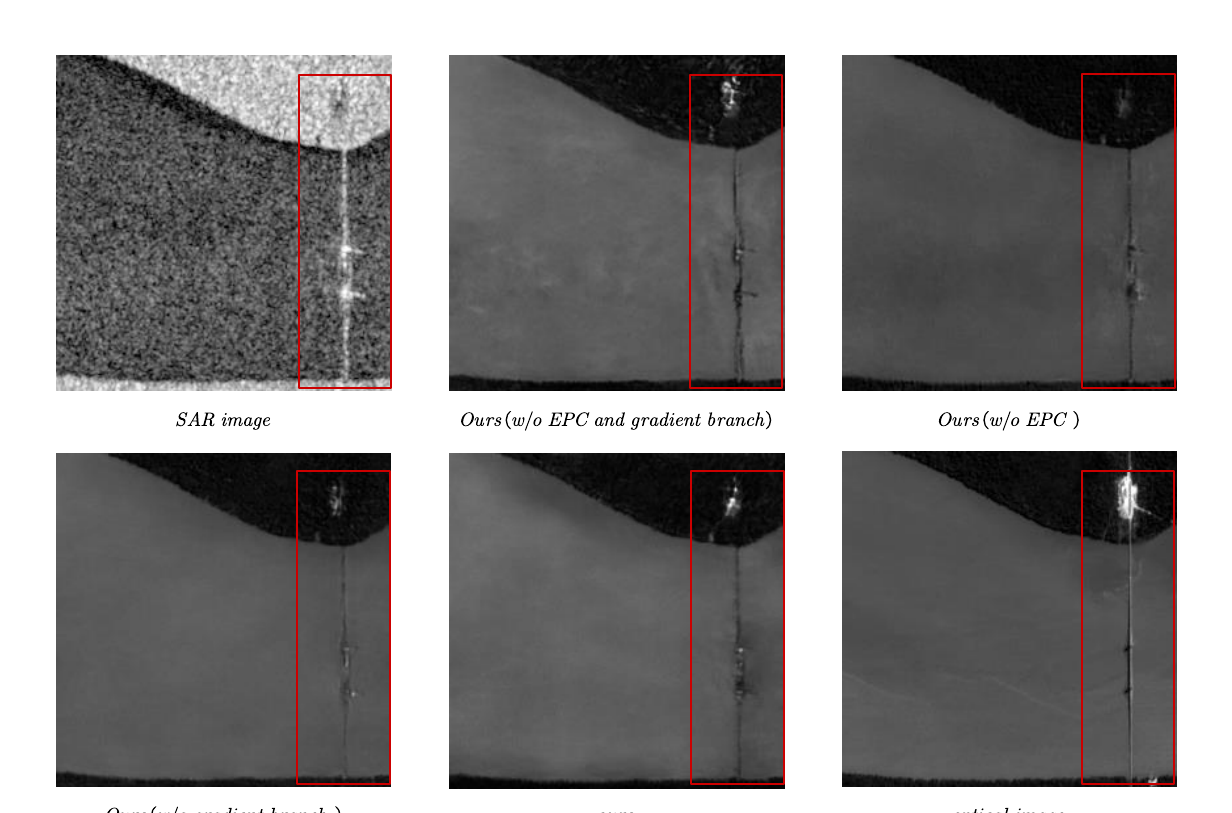
Figure 8. A visual comparison of ablation experiments. The size of all images is 256 ×